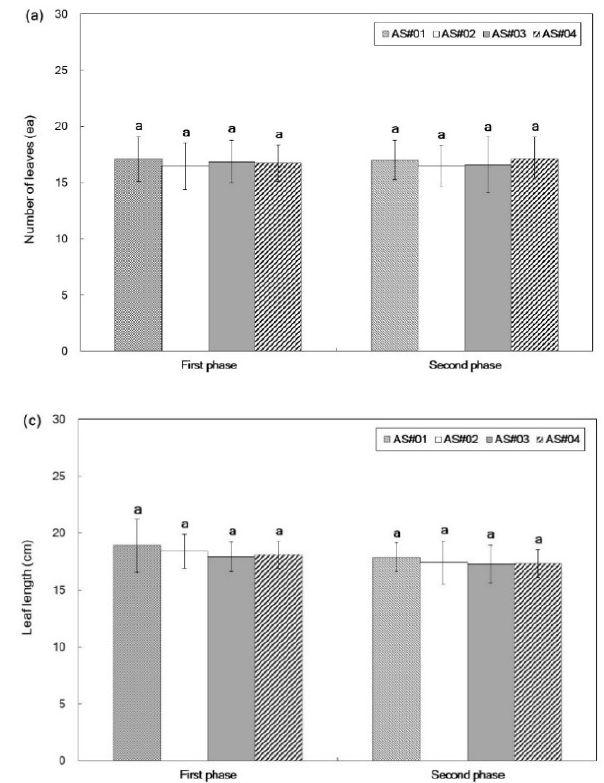
Figure 4. Effect of desalinated irrigation water on ( a ) number of leaves, ( b ) leaf width, and ( c ) leaf length. Bars represent the mean ± standard deviation, n = 20. Different letters indicate significant differences among treatments by Tukey’s honest significant difference test at p < 0.05. AS: after water treatment using the BWD system, i.e., desalinated water irrigation.